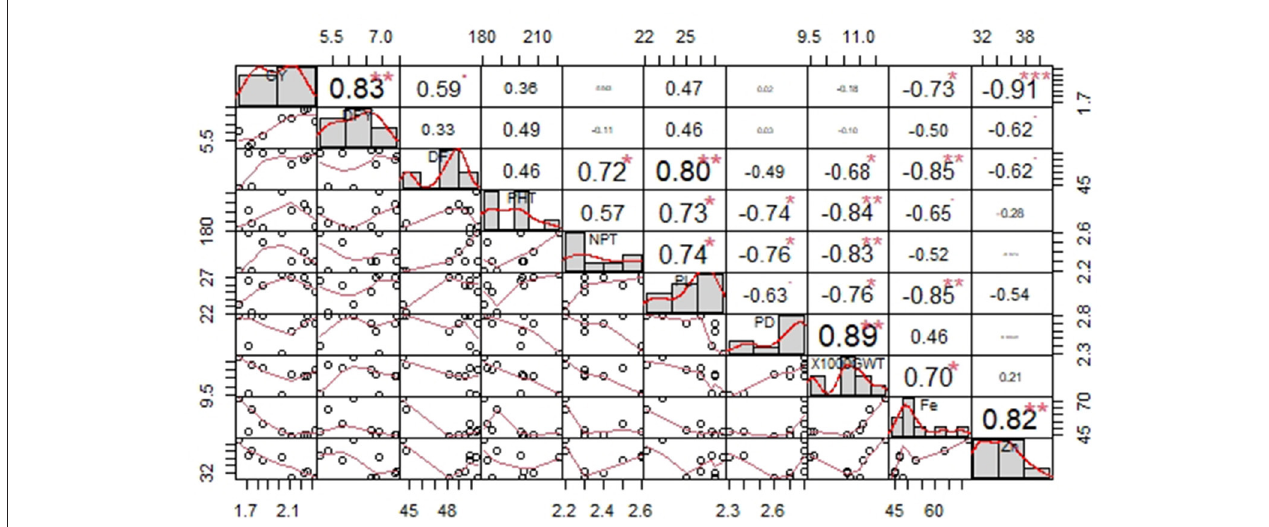
FIGURE 1 | Correlation among yield, quality, and agronomic traits recorded on nine OPVs over 20 locations. Significant effects at * P < 0.05, ** P < 0.01, *** P <